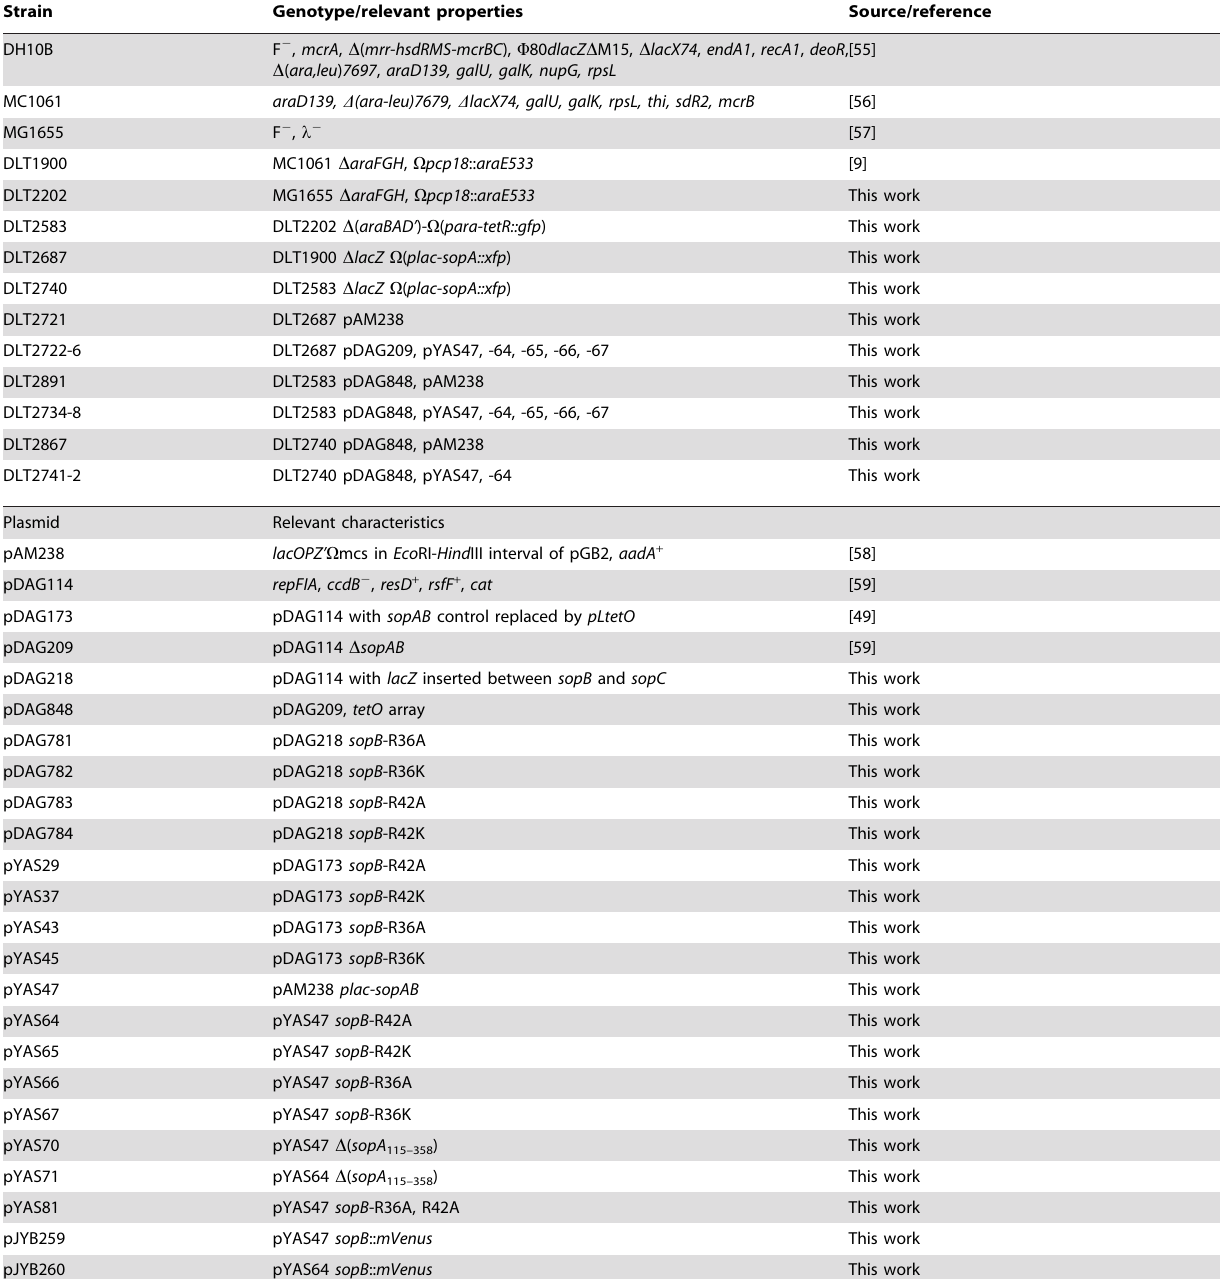
Strain Genotype/relevant